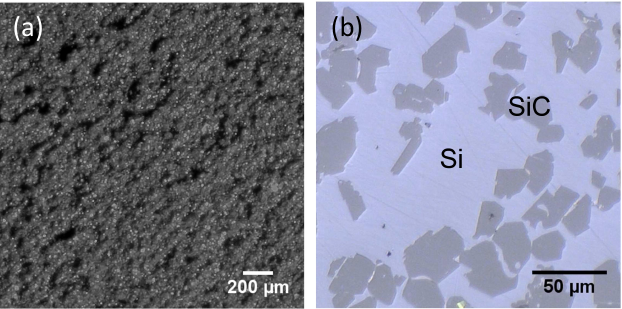
Figure 12. Optical microscopy of the laser-sintered ( a ) and infiltrated ( b ) Si-SiC material.